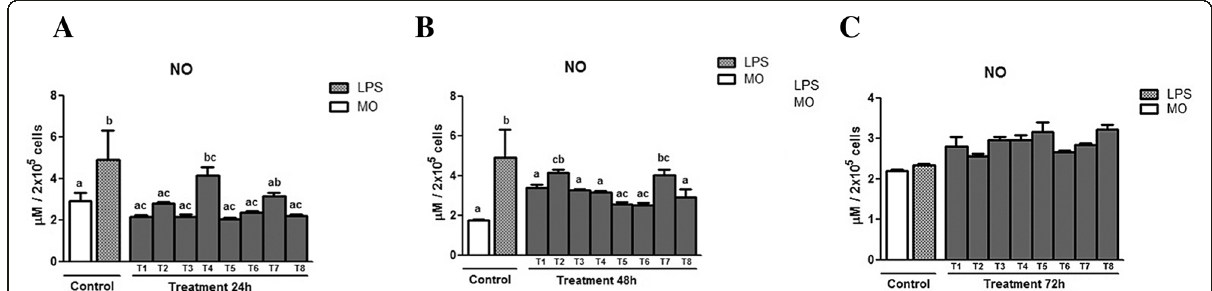
Fig. 5 Means± standard deviation of the mean ( p < 0.05) of NO production in supernatant of murine macrophages infected by L. (L.) chagasi treated with PLA 2 at three different incubation moments: ( a ) 24 h, ( b ) 48 h, and ( c ) 72 h. The control was done without treatment (MO) and with lipopolysaccharide (LPS). The PLA 2 doses utilized in the treatment (T) were T1 = 100 μ g/mL; T2 = 50 μ g/mL; T3 = 25 μ g/mL; T4 = 12.5 μ g/mL;